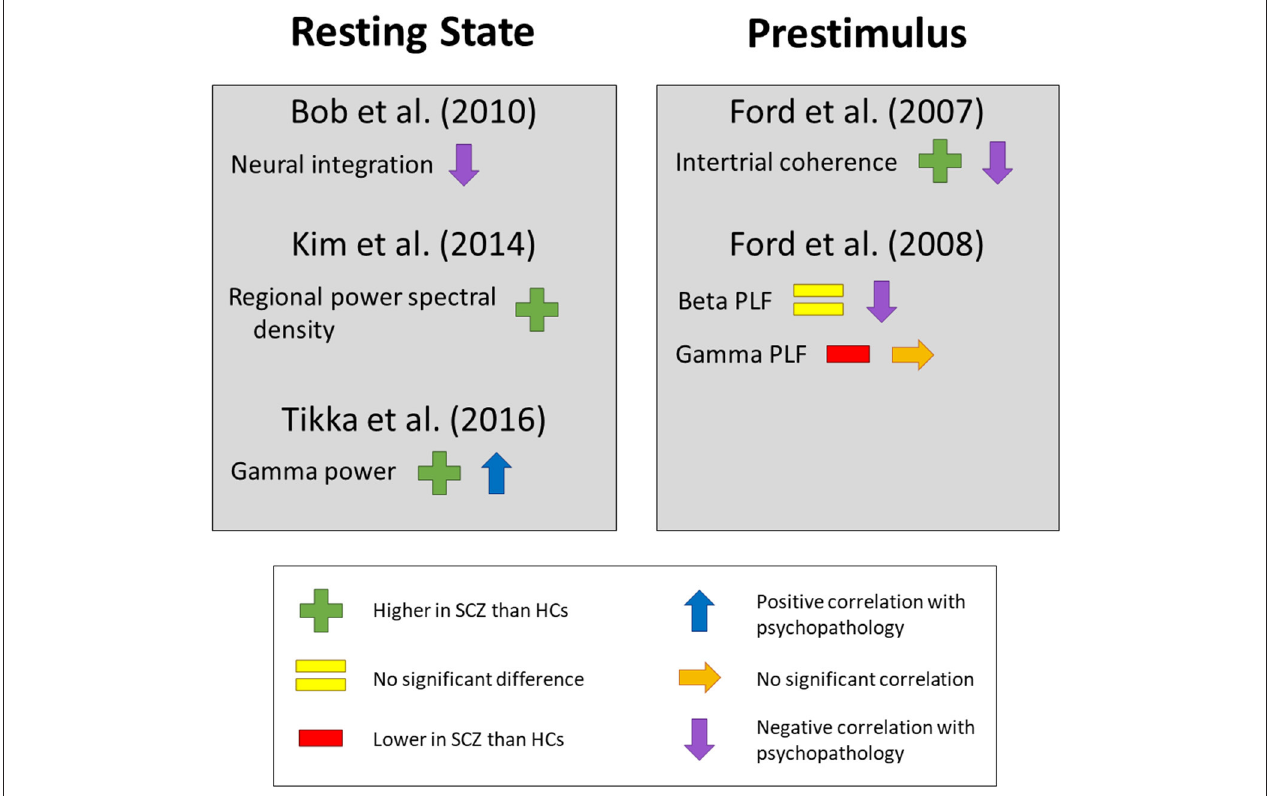
FIGURE 7 | Changes in resting state and prestimulus measures. Findings on the resting state and prestimulus period, including comparisons of subjects with schizophrenia to healthy controls and correlations with psychopathology scales. SCZ, subjects with schizophrenia. HCs, healthy controls. PLF, phase-locking factor. Neural integration ( 47) was computed as correlations between 16 electrode pairs. For the resting state findings, a direct link to the self was established only by Bob et al. ( 47), by correlation with the Dissociative Experiences Scale. For the prestimulus findings, a direct link to the self was established only by Ford et al. (2007) in their comparison of patients and controls, through an interaction effect with experimental condition. This figure does not show findings from studies examining rest/task differences or prestimulus/task differences, as these were shown in Figure 6 .